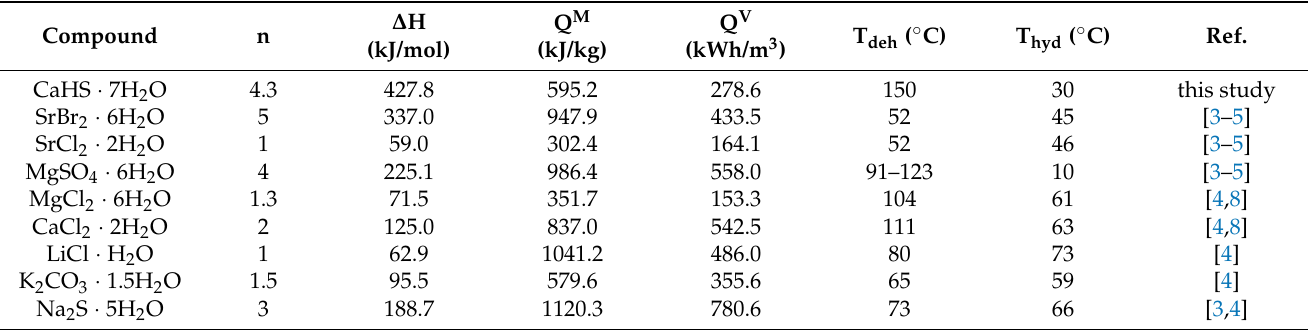
Table 1. List of thermophysical characteristics (moles of H 2 O involved in the dehydration process (n); molar enthalpy of dehydration per moles of material ( ∆ H (kJ/mol)); heat storage capacity per mass (Q M ); and volume (Q V ) of material) and working conditions (dehydration (T deh ) and hydration (T hyd ) temperatures) of CaHS and other selected common inorganic salt